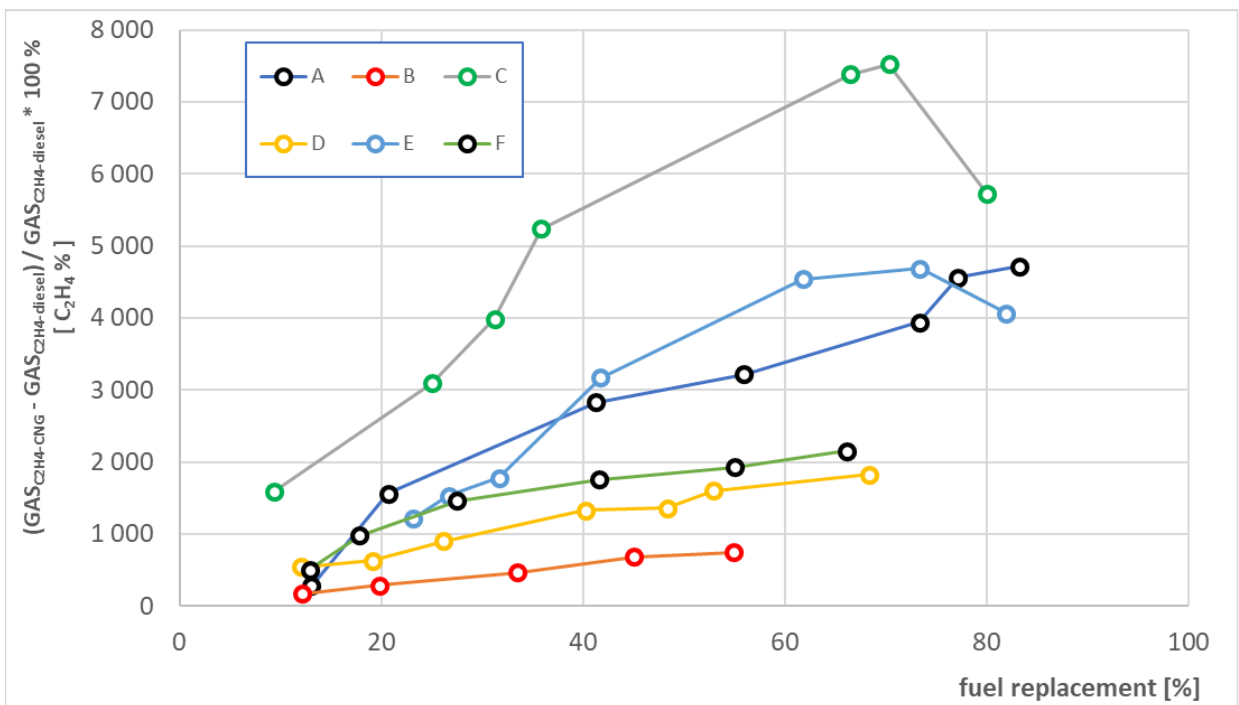
Figure 18. Curves from A to F showing the changes in the emission of ethene as the comparison of exhaust gas temperature noted only in single fuel (diesel) working mode for individual engine operating points, where the rotation speed, power, and torque were constant, as a dual-fuel mode (where engine uses CNG and diesel fuel) replacement function.